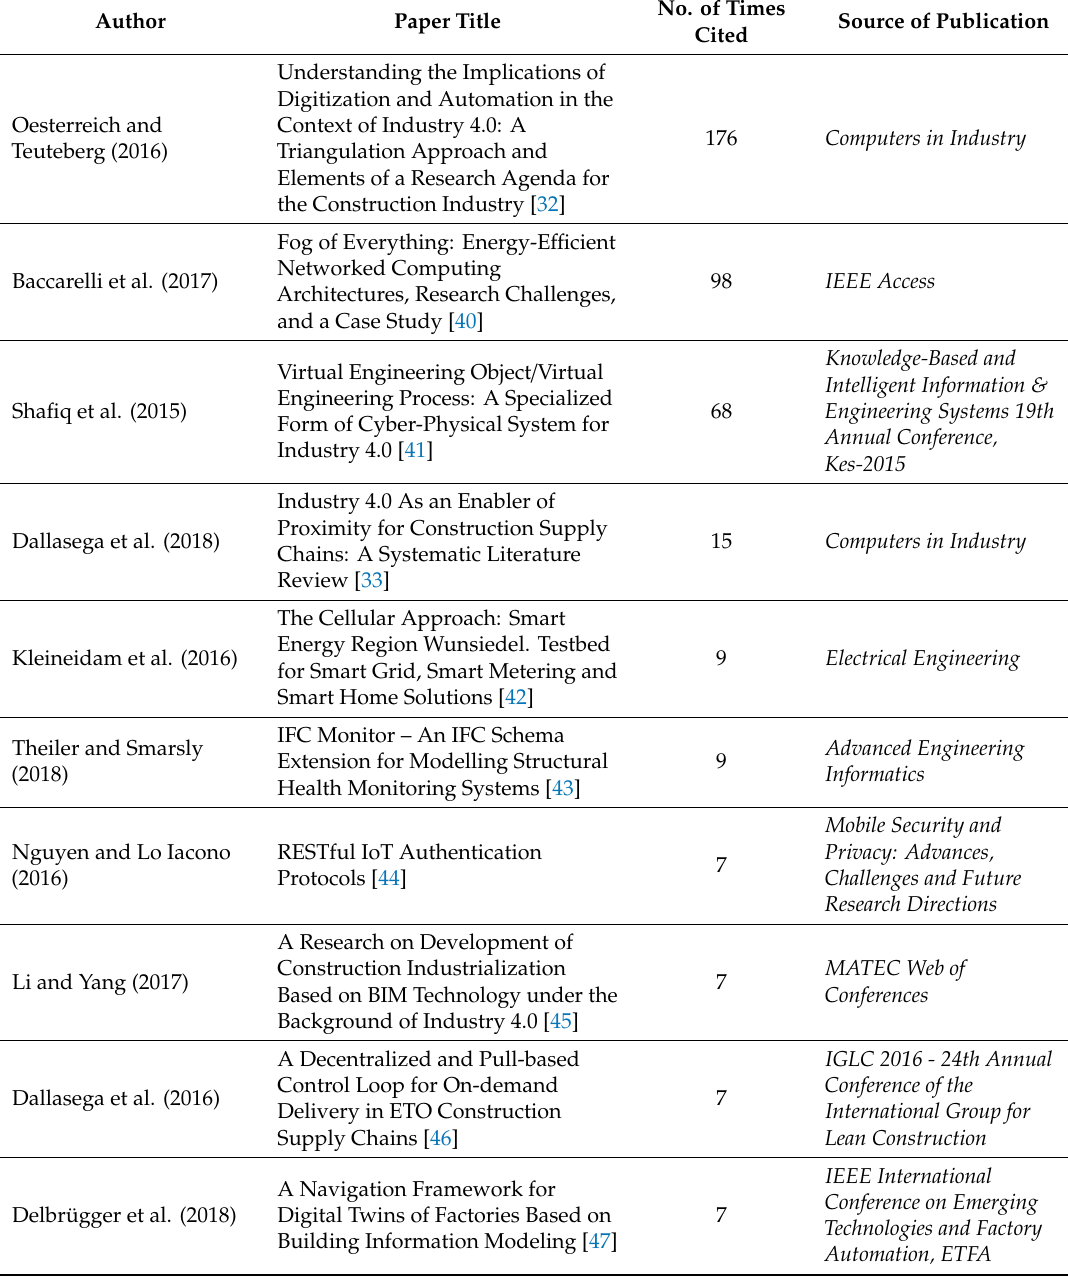
Table 11. Most frequently cited